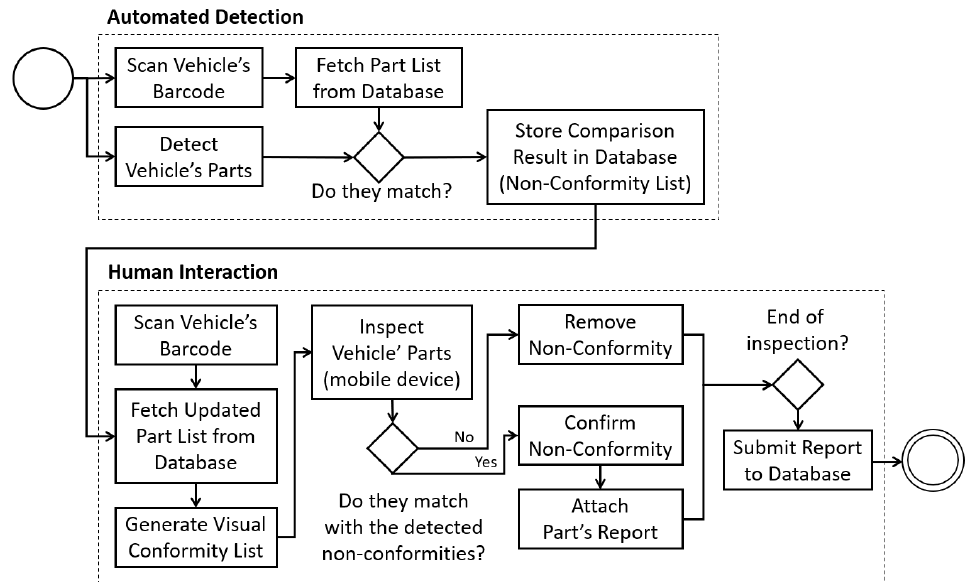
Figure 2. System architecture of the final quality control support tool, that combines automated non-conformity detection with human